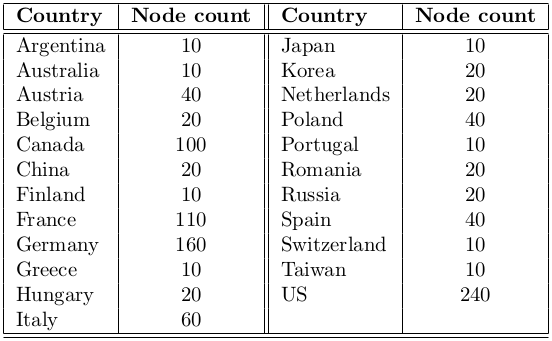
Table from the paper: End-Host Distribution in Application-Layer Multicast: Main Issues and Solutions
Table text:
Country
Nodecount
Country
Nodecount
Argentina
10
Japan
10
Australia
10
Korea
20
Austria
40
Netherlands
20
Belgium
20
Poland
40
Canada
100
Portugal
10
China
20
Romania
20
Finland
10
Russia
20
France
110
Spain
40
Germany
160
Switzerland
10
Greece
10
Taiwan
10
Hungary
20
US
240
Italy
60